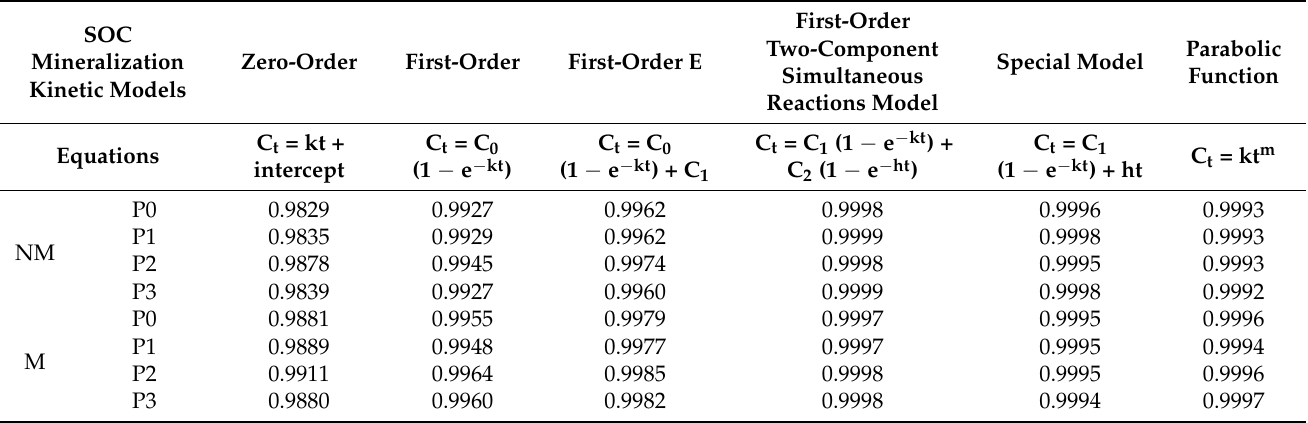
Table 1. Kinetic models to describe SOC mineralization. The determination coefficient (R 2 ) is displayed and used to evaluate goodness-of-fit for comparing kinetic